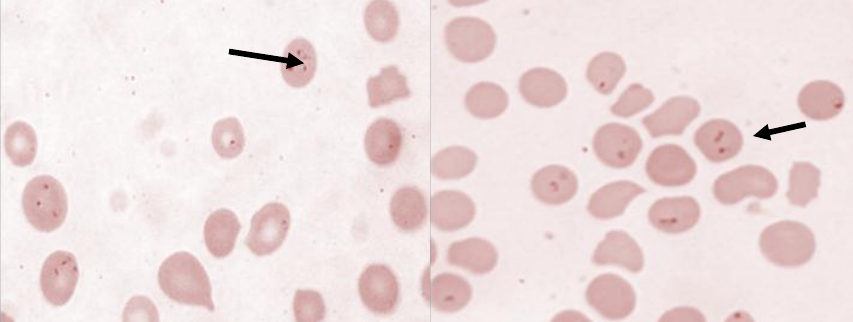
Figure 1: Giemsa-stained blood smears of infected cattle reveal the presence of intra- erythrocytic forms (arrows) morphologically compatible with theilerial piroplasms. Some of the infected erythrocytes showed morphological disorders represented by round-shaped appearance and irregular thorn-like protrusions (X 1000).